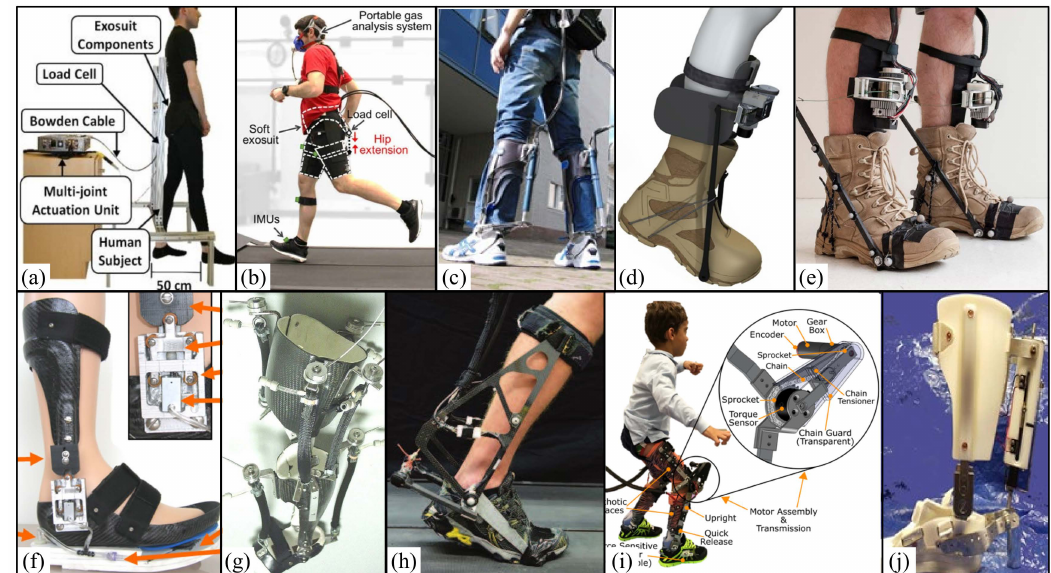
Figure 4. Single-joint powered lower limb assisted exoskeletons. ( a ) Harvard University, SE [66]. ( b ) Harvard University, TSE [67]. ( c ) Achilles exoskeleton [71]. ( d ) MIT, AAE [72]. ( e ) MIT, AAE [74]. ( f ) University of Illinois KFO [69]. ( g ) University of Michigan, KAFO [70]. ( h ) Carnegie Mellon University, AE [73]. ( i ) National Institutes of Health, RETCG [4]. ( j ) Arizona State